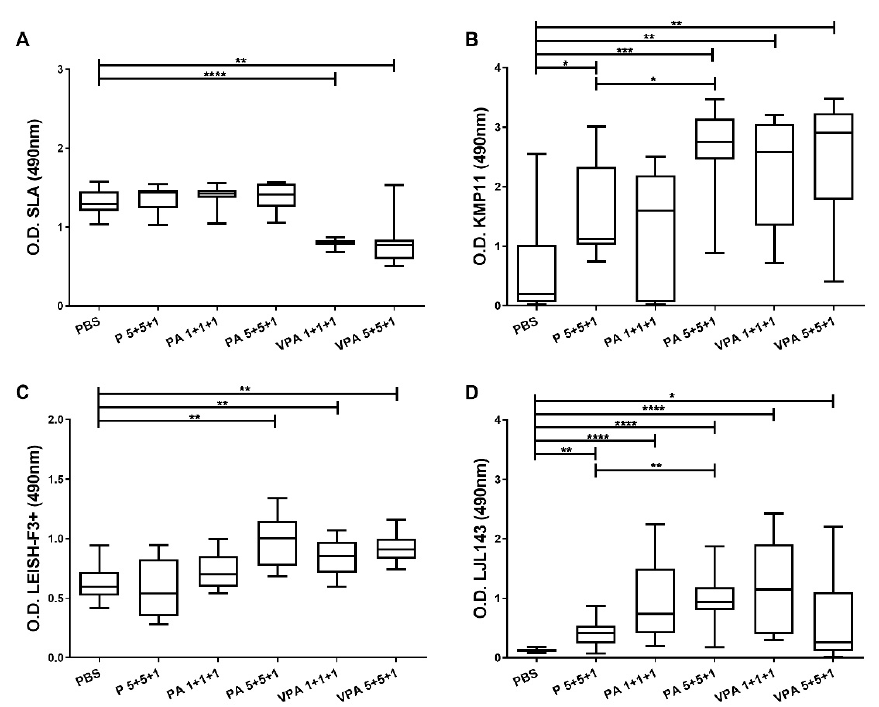
Figure 2. Specific IgG responses after L. infantum challenge. One month after the last immunization, the hamsters were infected intracardially with 2 × 10 7 L. infantum stationary-phase promastigotes. Twelve weeks later, they were euthanized, and plasma was obtained. Specific antibody reactivity against SLA ( A ), and against the specific proteins KMP11 ( B ), LEISH-F3+ ( C ), and LJL143 ( D ), was assessed by ELISA. The results are shown as whisker (min to max) plots for each group ( n = 9). Significant differences between groups are indicated (Mann–Whitney U test): * p < 0.05; ** p < 0.01; *** p < 0.001; **** p <